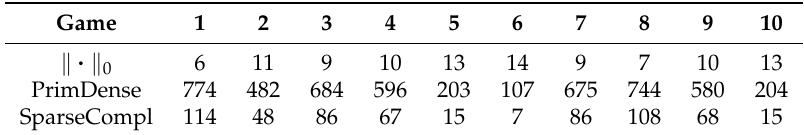
Table legend: Game—Tested 10 games; (cid:107) · (cid:107) 0 —The number of positive components in the densest equilibrium; PrimDense—Time in seconds using Algorithm 3, the primary dense Shapley-Snow algorithm;